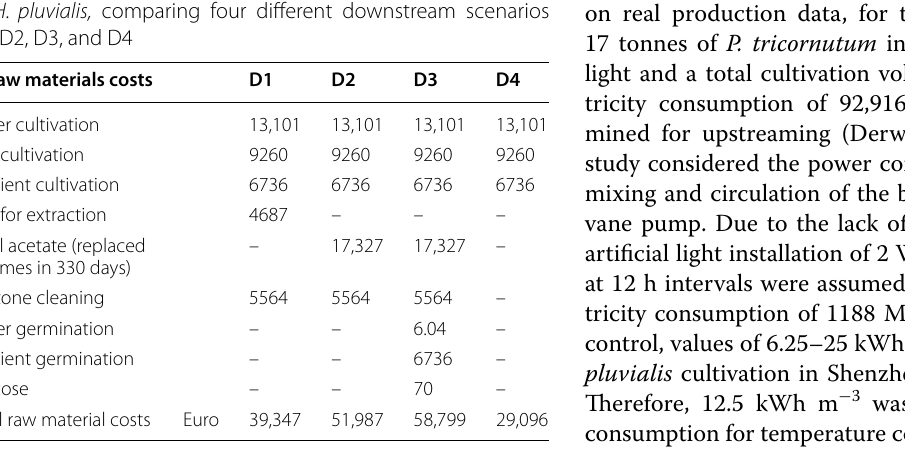
II) of the biotechnological production of astaxanthin from H. pluvialis comparing four +